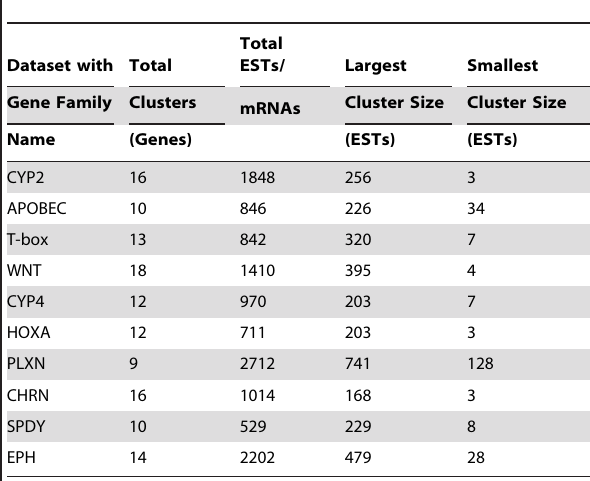
Table 1. The details of the ten datasets extracted using the tools in the genome